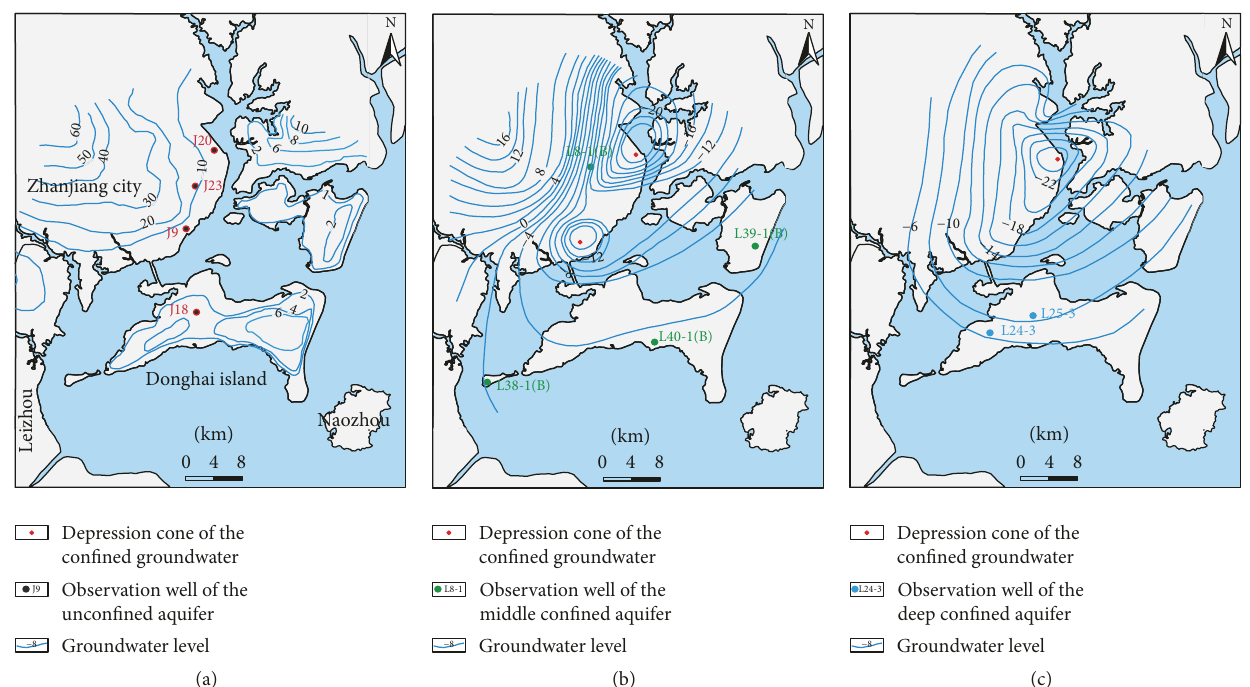
Figure 3: Groundwater level contour maps for the multilayered aquifer system: (a) the unconfined aquifer, (b) the middle confined aquifer, and (c) the deep confined